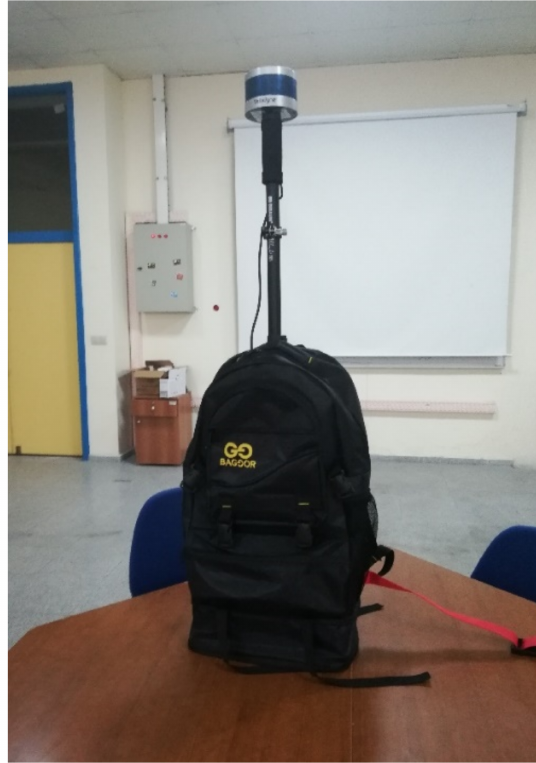
Figure 1. Mobile Mapping System used for